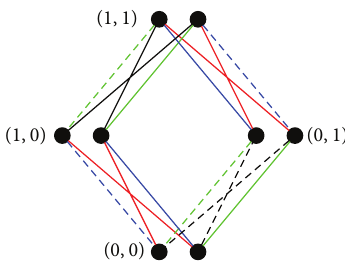
Figure 4: A 2 D Adinkra with (2,2) colors. The grading coordinates are given next to the nodes as (ℎ 𝐿 , ℎ 𝑅 ) .